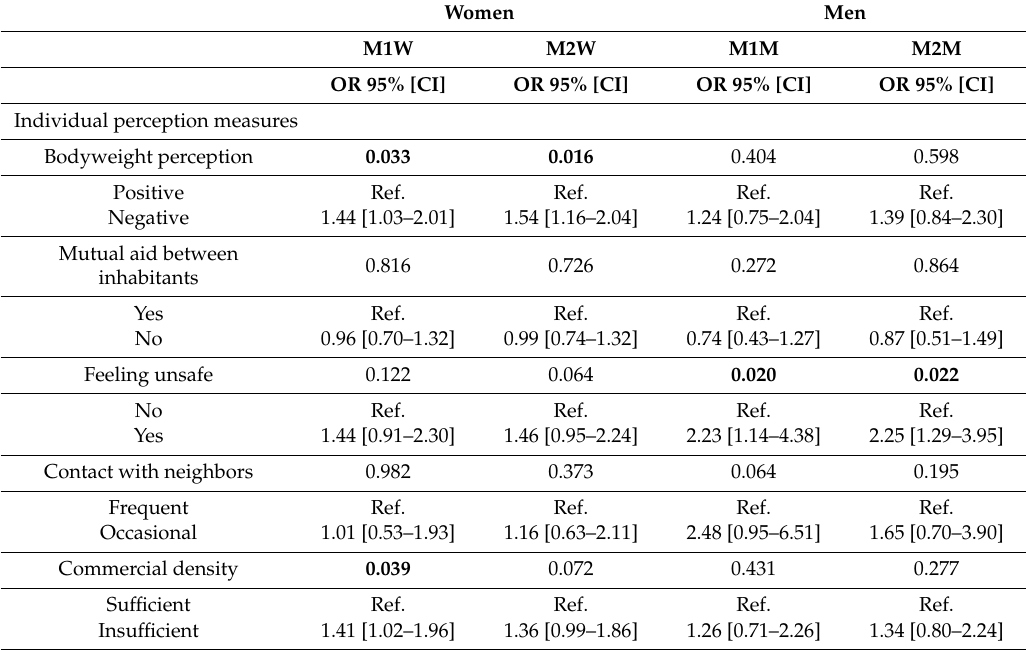
Table 4. Multivariate analysis of the associations between contextual neighborhood characteristics and depression in women and men, SIRS,